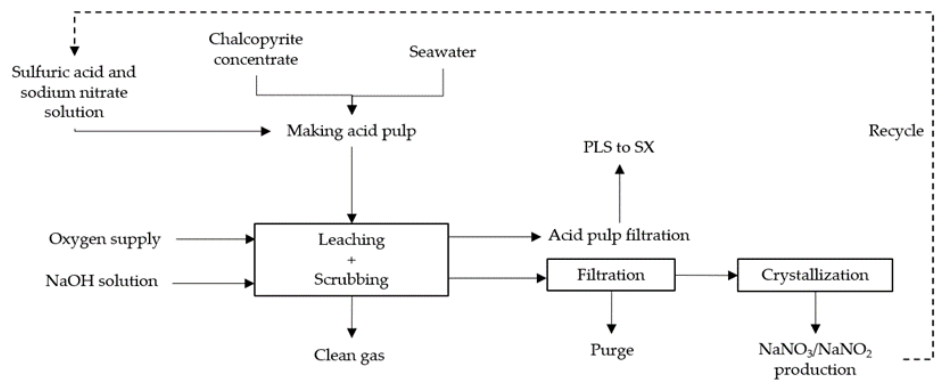
Figure 13. Proposed process for chalcopyrite leaching.